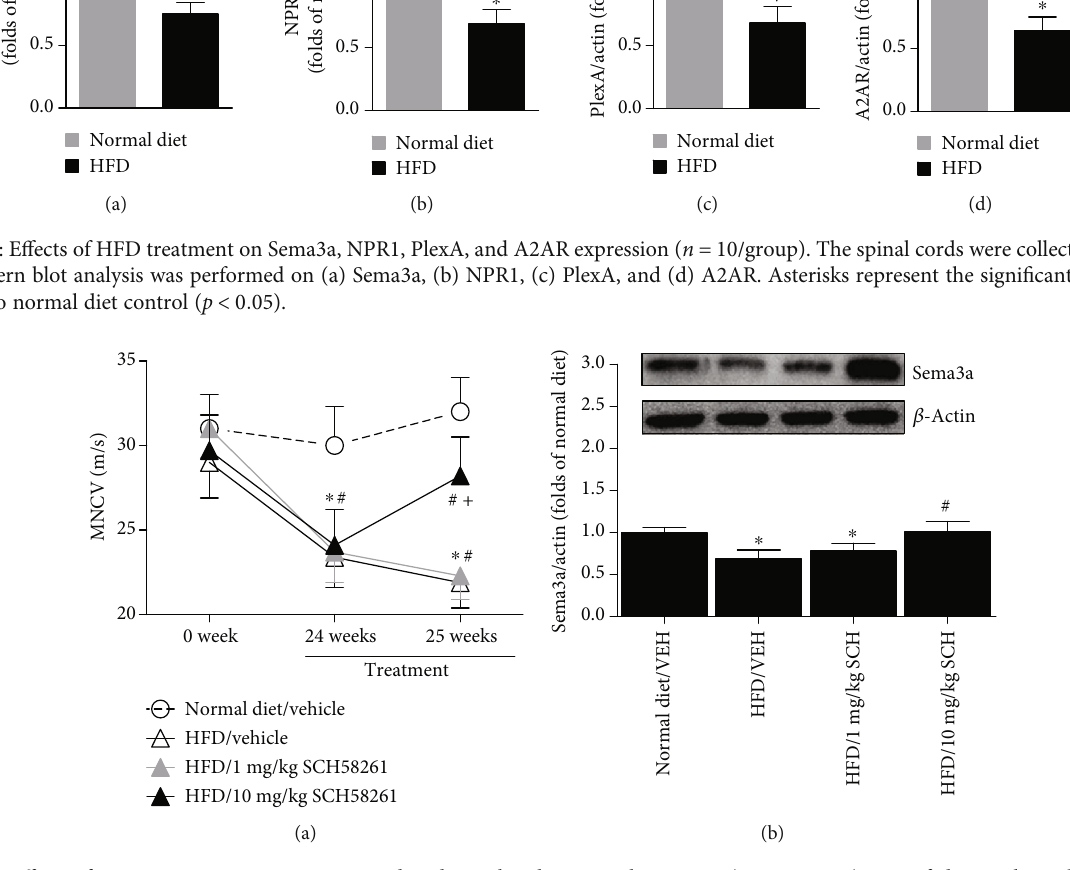
Figure 3: E ff ects of SCH58261 treatment on HFD-induced peripheral neuropathy in mice ( n = 10/group ). HFD-fed mice showed (a) slower motor nerve conduction velocity (MNCV) and (b) lower expression of Sema3a in the spinal cord. SCH58261 treatment (SCH) started at week 24 and was performed once daily for one week. The mice were tested for MNCV at week 25 and sacri fi ced for Western blot analysis. Asterisks represent the signi fi cant di ff erence relative to normal diet control ( p < 0 : 05 ). Pounds represent the signi fi cant di ff erence relative to vehicle (VEH) ( p < 0 : 05